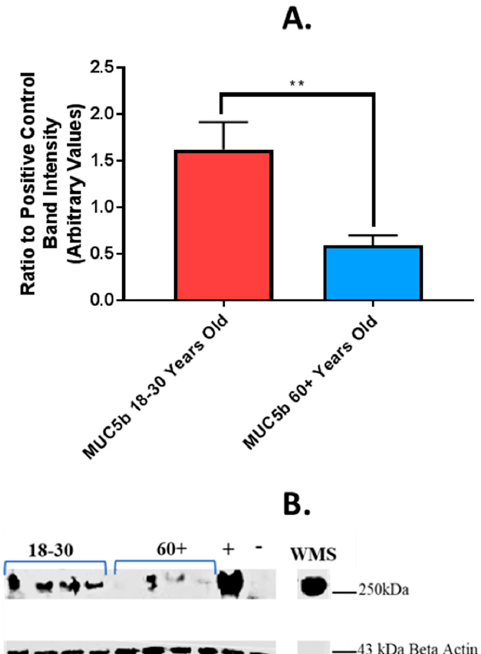
Figure 4. Binding of MUC5b from UWS of older and younger adults to oral epithelial cells. ( A ) Mean ( +/ − SEM) binding of MUC5b from UWS of older ( n = 21) and younger ( n = 29) adults to TR146 / MUC1 cells. MUC5b was quantified by blotting with anti-MUC5b antibody. ( B ) Representative image of immuno-blot for MUC5b ( > 250 kDa) from UWS of older and younger adults, binding to TR146 / MUC1 cells. + = binding of control UWS sample, − = negative control (no WS), WS = control WS sample run as a comparison. Beta actin (43 kDa) used as loading control. Di ff erence in means between groups tested for statistical significance using student’s t test. p = < 0.05 * p = < 0.01 **.